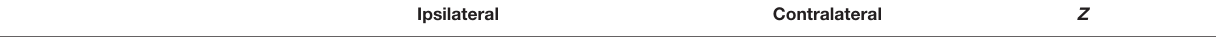
TABLE 2 | WMH volume ipsilateral and contralateral to the intracranial atherosclerosis site.